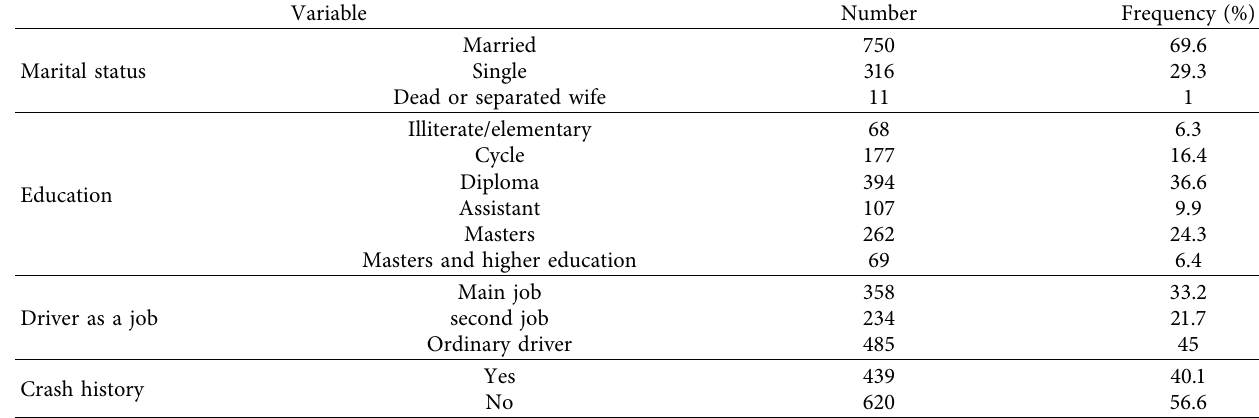
Table 1: Frequency distribution of demographic variables of drivers participating in the study.